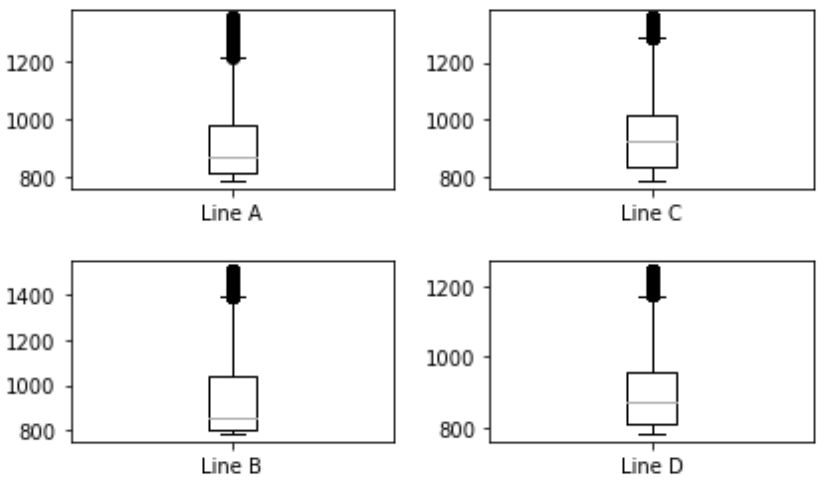
Figure 5. Boxplot for the cycle time per line, without outliers. Thus, for the inclusion of variability in the computation of product costs, the cycle times associated to Q1 and Q3 and the confidence interval for the mean are used. Both can be calculated or estimated for each workstation or just considering the bottleneck of the line (in this case, workstation 17). The analysis made was used to compare production lines; thus, it was centered on the bottleneck which defines the production speed of the line. After this high-level approach to optimize production lines, a detailed analysis within each line should be made to analyze and optimize workstations.